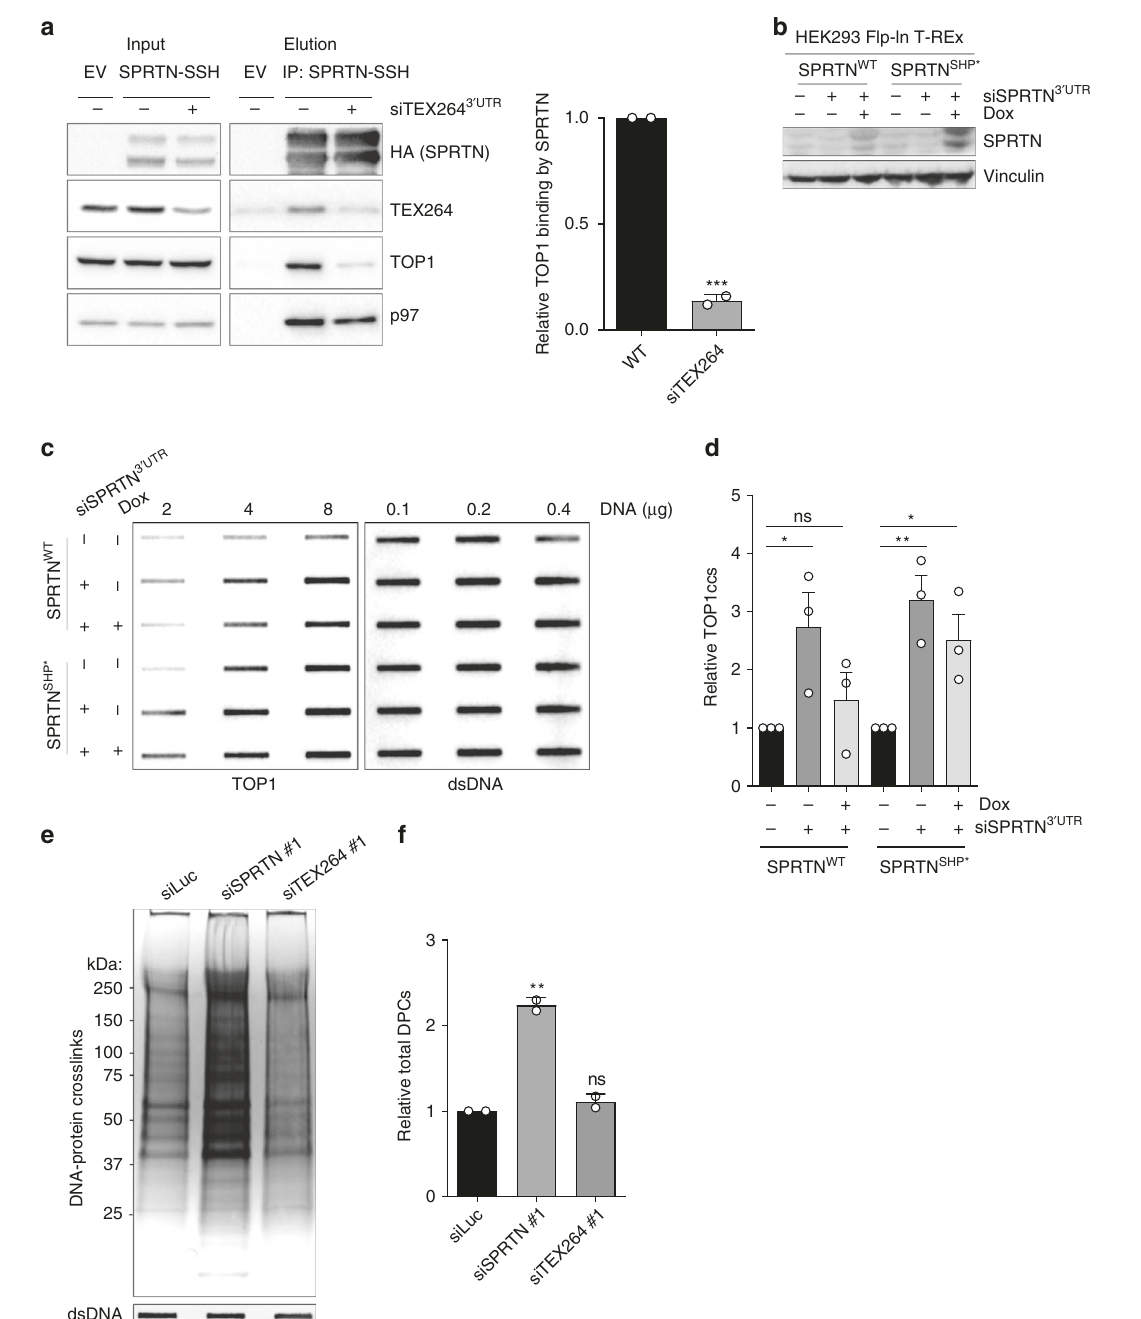
Fig. 5 TEX264 cooperates with the metalloprotease SPRTN in TOP1cc repair. a Left: analysis of anti-Strep-tag immunoprecipitates prepared from HEK293 cells expressing SPRTN-SSH, transfected with the indicated siRNAs. Right: corresponding quanti fi cation of two independent experiments (mean ± SD; *** P < 0.0005). b Immunoblots to con fi rm SPRTN depletion/induction in doxycycline (Dox)-inducible HEK293 Flp-In T-REx cells used in c and d . Cells were transfected with siRNA targeting the 3 ′ UTR of SPRTN 3 days prior to collection. Dox was added for the fi nal 24 h. c TOP1cc detection by RADAR in same cells as b . d Quanti fi cation of c (error bars represent mean ± SEM; Student ’ s t -test; n = 3; * P < 0.05; ** P < 0.01; ns, not signi fi cant). e Total DNA – protein crosslinks isolated by RADAR from HEK293 cells treated with the indicated siRNAs. DPCs were resolved by SDS – PAGE and visualised by silver staining. f Quanti fi cation of e (error bars represent mean ± SD; n = 2; ** P < 0.01; ns, not signi fi cant; Student ’ s t -test). Source data are available